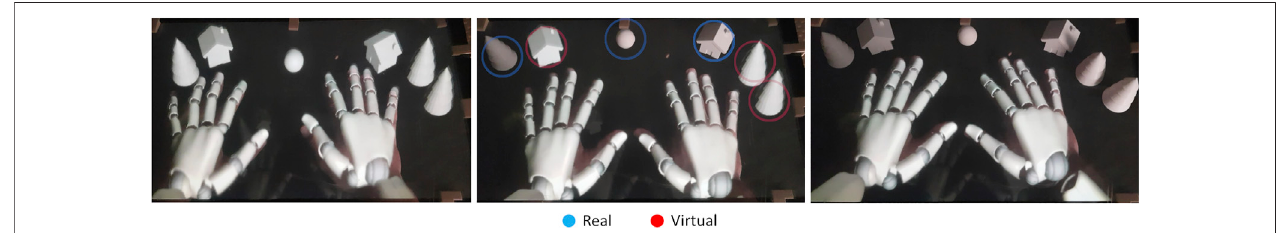
FIGURE 2 | The three experimental conditions represented from the participant ’ s point of view (Left) The “ VIRTUAL ” condition where all the objects were virtual (Middle) The “ MIXED ” condition where there were both real and virtual objects mixed (Right) The “ REAL ” condition where all objects were real. The 3D rendering allowed virtual objects to appear having the same 3D volume as their real